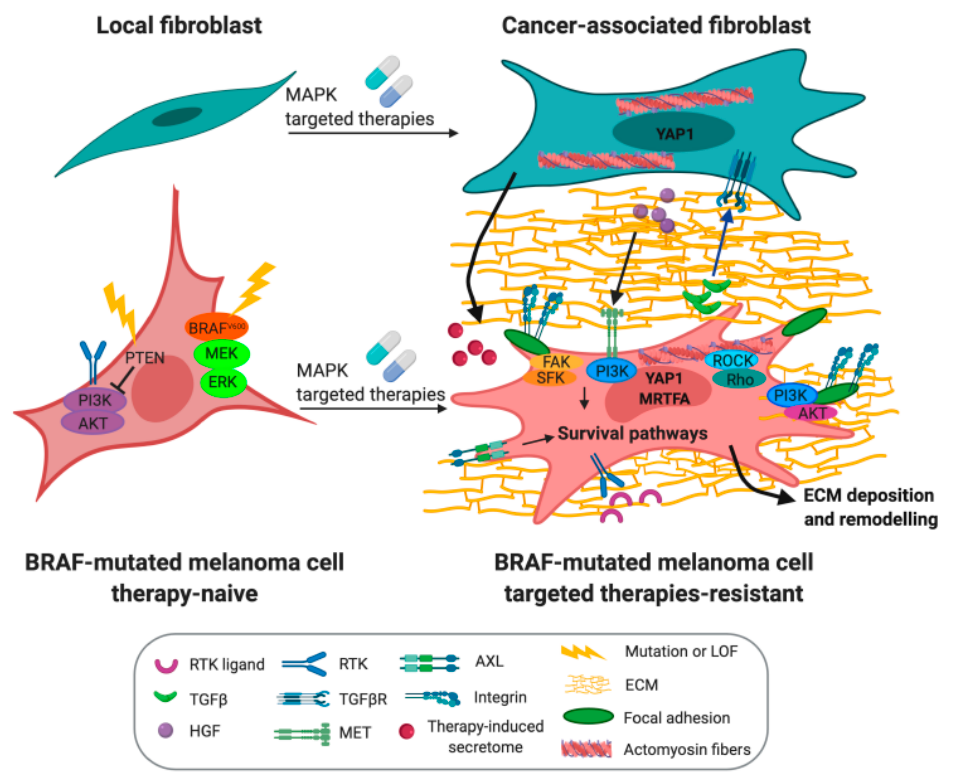
Figure 3. MAPK pathway inhibition mediates tumor microenvironment remodeling as a source of therapy resistance. Melanoma cells and cancer-associated fibroblasts cross-talk mediates therapeutic escape from MAPK-targeted therapies. MEK: mitogen-activated protein kinase kinase; ERK: extracellular signal-regulated kinase; RTK: receptor tyrosine kinase; TGF β : transforming growth factor β ; HGF: hepatocyte growth factor; TGF β R: transforming growth factor beta receptor; MET: hepatocyte growth factor receptor; AXL: AXL receptor tyrosine kinase; ECM: extracellular matrix; FAK: focal adhesion kinase; PTEN: phosphatase and Tensin homolog; PI3K: phosphoinositide 3-kinase; SFK: Src family kinase; ROCK: Rho-associated protein kinase; YAP1: Yes-associated protein 1; MRTFA: myocardin-related transcription factor A.